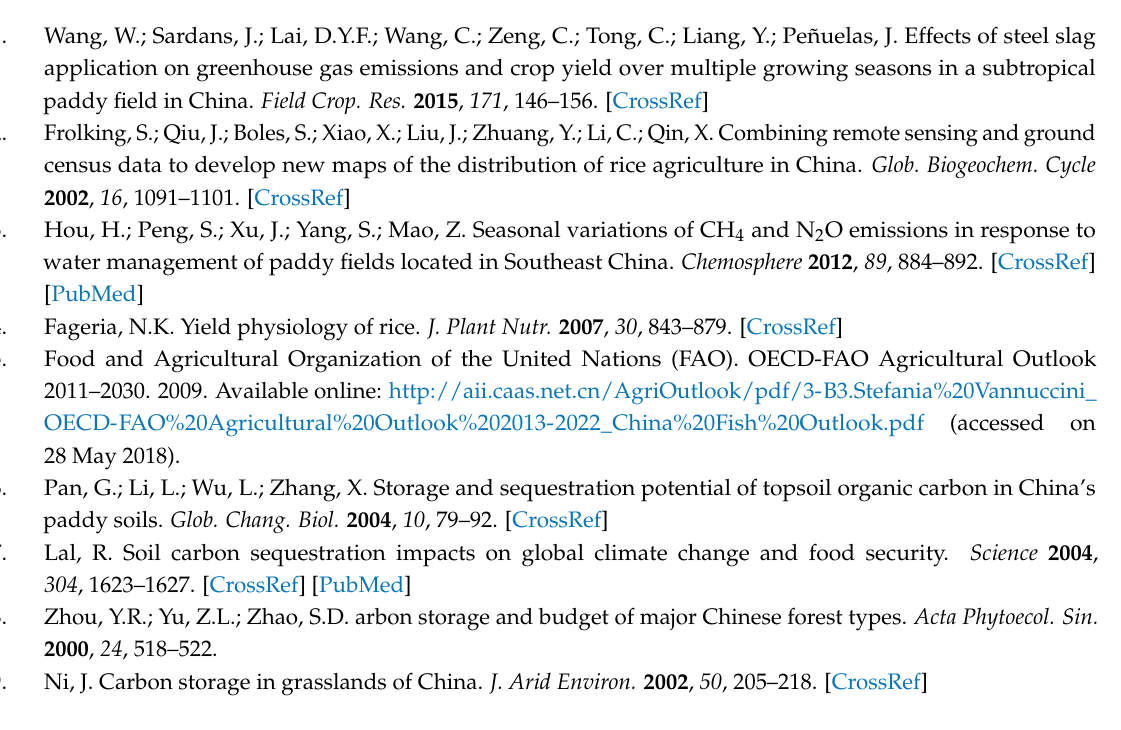
Figure S1: Temporal variations of air temperature (A) and rainfall (B) in the study area, Figure S2: Mean ratios of LOC:TOC (A,B), MBC:TOC (C,D), and DOC:TOC (E,F) in the treatment and control plots in the early and late paddy fields. Different letters represent significant difference in mean values among treatments ( p < 0.05, n = 6), Figure S3: Mean total stocks of SOC (A,B), LOC (C,D), MBC (E,F), and DOC (G,H) in the treatment and control plots in the early and late paddy fields. Different letters represent significant difference in mean values among treatments ( p < 0.05, n = 6), Table S1: Characteristics of steel slag and biochar used in this study, Table S2: Pearson correlation coefficients between soil organic carbon fractions, Table S3: Pearson correlation coefficients between the total stocks of different carbon forms and various soil